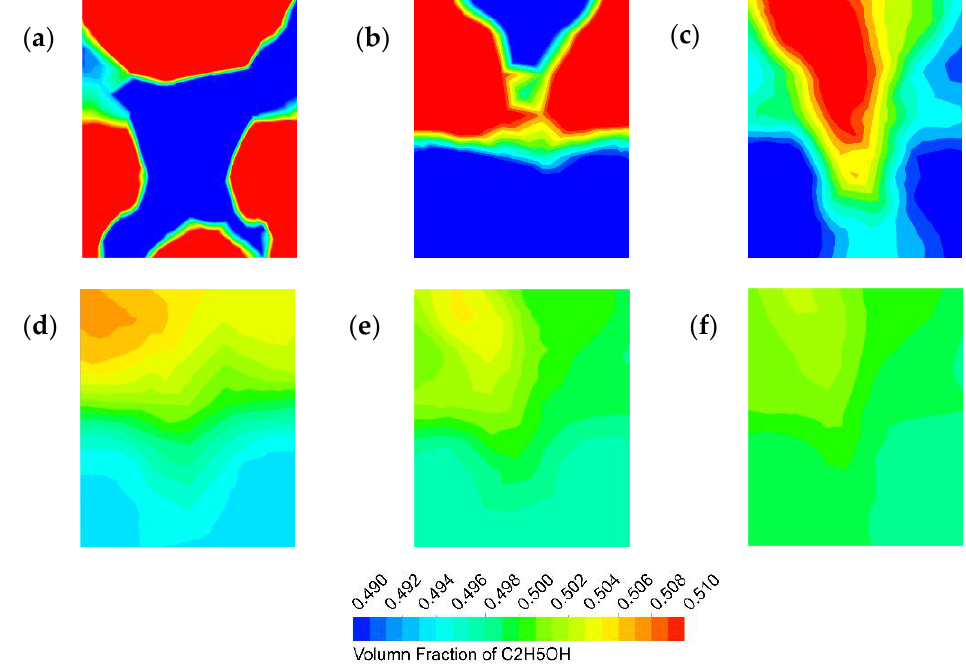
Figure 6. Contours of the ethanol volume fraction at cross-sections with different flow distances (40 mL/min): ( a ) 11 mm; ( b ) 22 mm; ( c ) 33 mm; ( d ) 44 mm; ( e ) 55 mm; and ( f ) 66 mm.